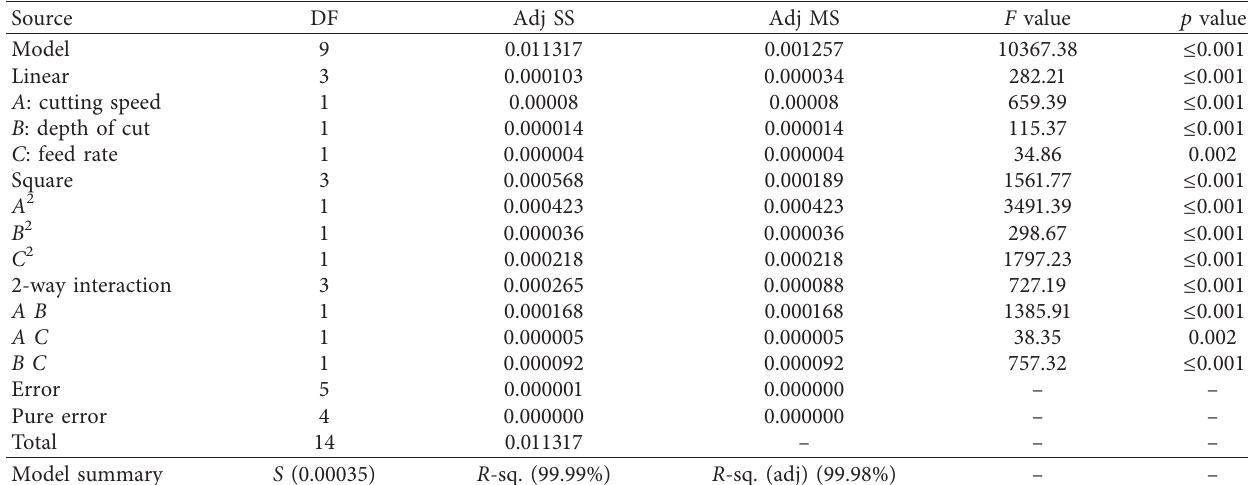
Table 3: Analysis of variance for